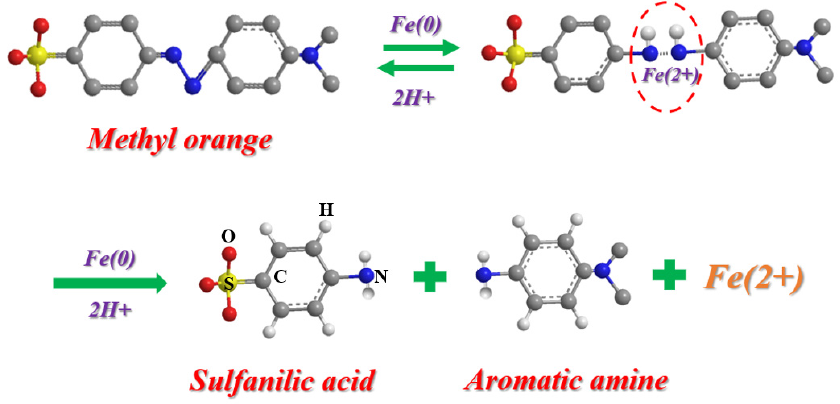
Figure 19. Zero-valent iron degradation process of methyl orange.